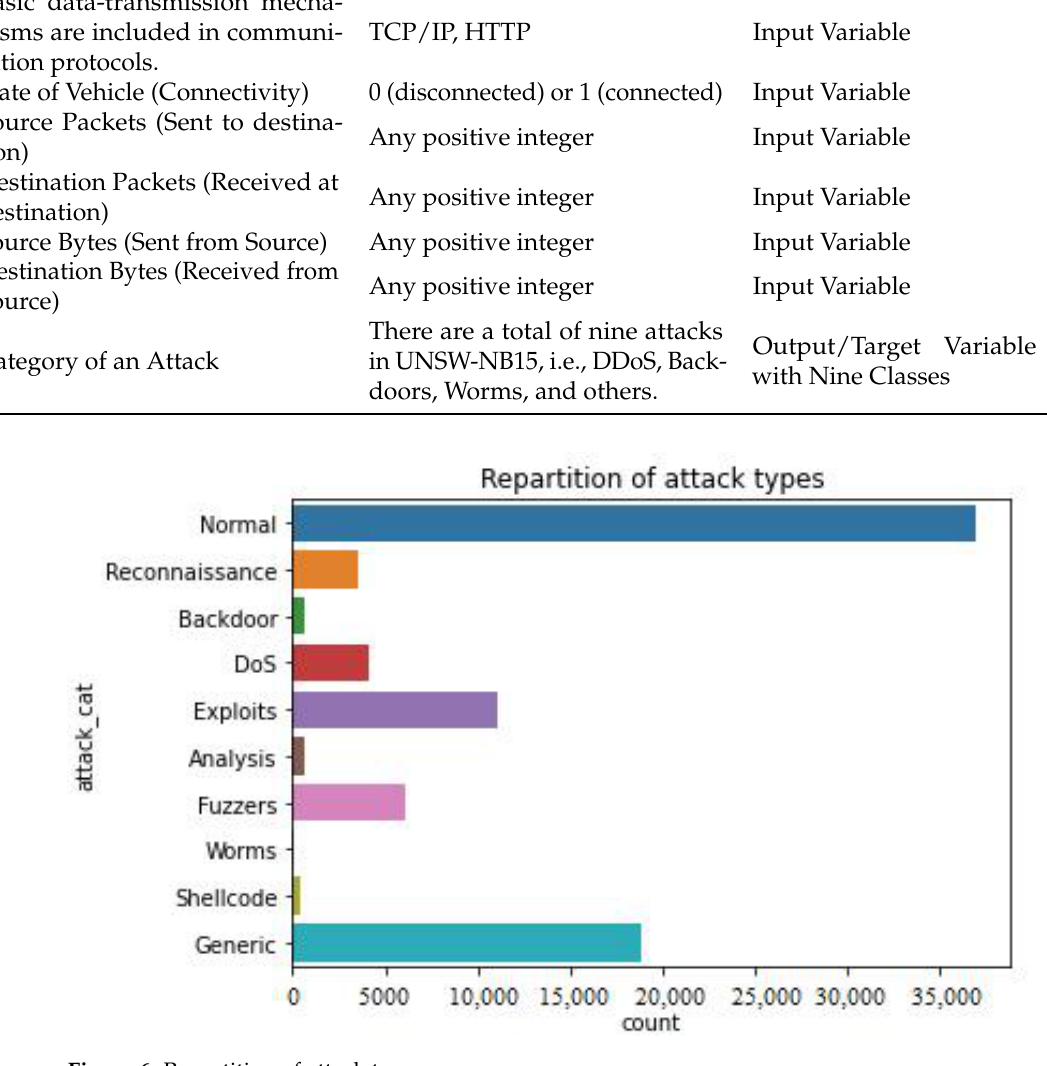
Figure 6. Repartition of attack